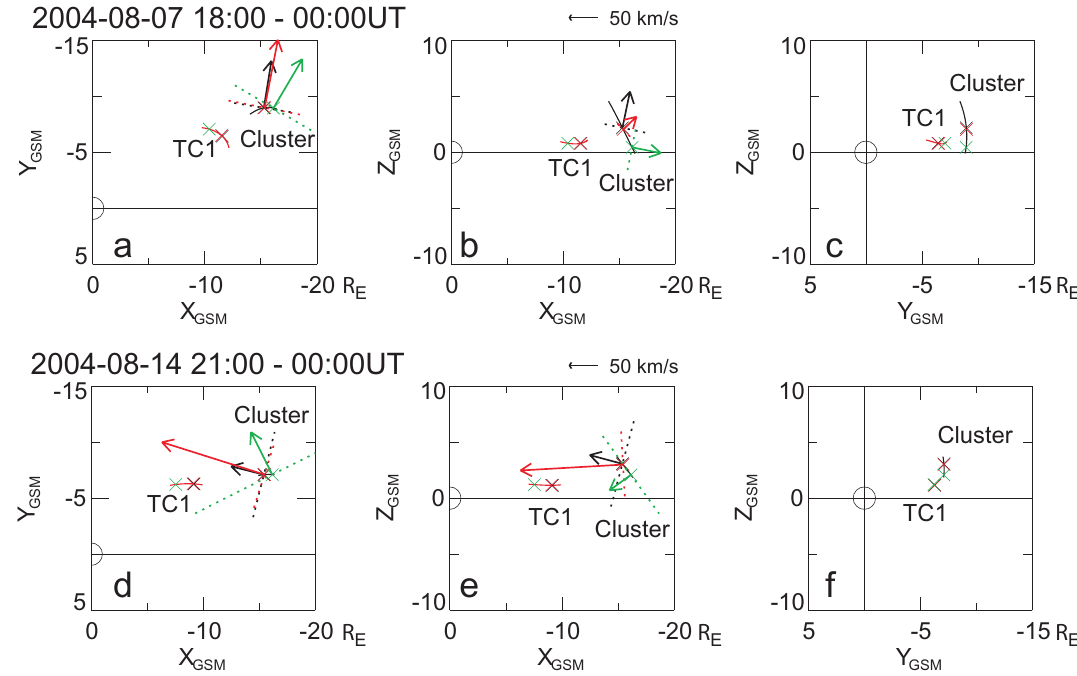
Fig. 4. Cluster and Double Star TC-1 orbit between 18:00 and 24:00 UT on 7 August 2004 (upper three panels) and between 21:00 and 24:00 UT on 14 August 2004 (lower three panels) in the X - Y plane (a, d) , in the X - Z (b, e) , and in the Y - Z plane (c, f) plotted in GSM. The color crosses show the spacecraft location and the arrows show the motion of the dipolarization front for each event expressed with different colors: 7 August, 20:33 UT (black), 20:44 UT (red), and 20:58 UT (green); 14 August, 21:55 UT (black), 22:02 UT (red), 23:33 UT (green). The dashed lines show the possible spatial scale if it is assumed that the front also will encounter (or had encountered)